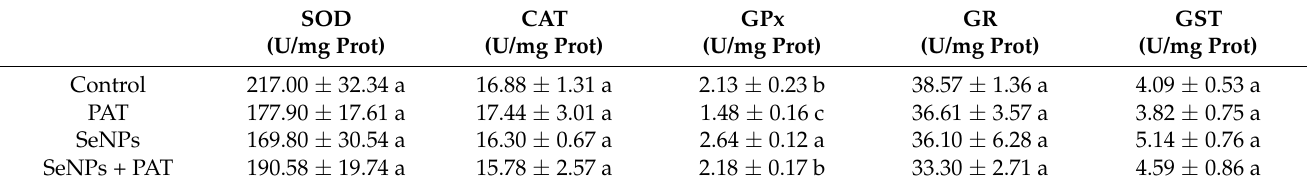
Table 3. Effect of SeNPs on SOD, CAT, GPx, GR and GST activities in kidney of PAT-treated mice